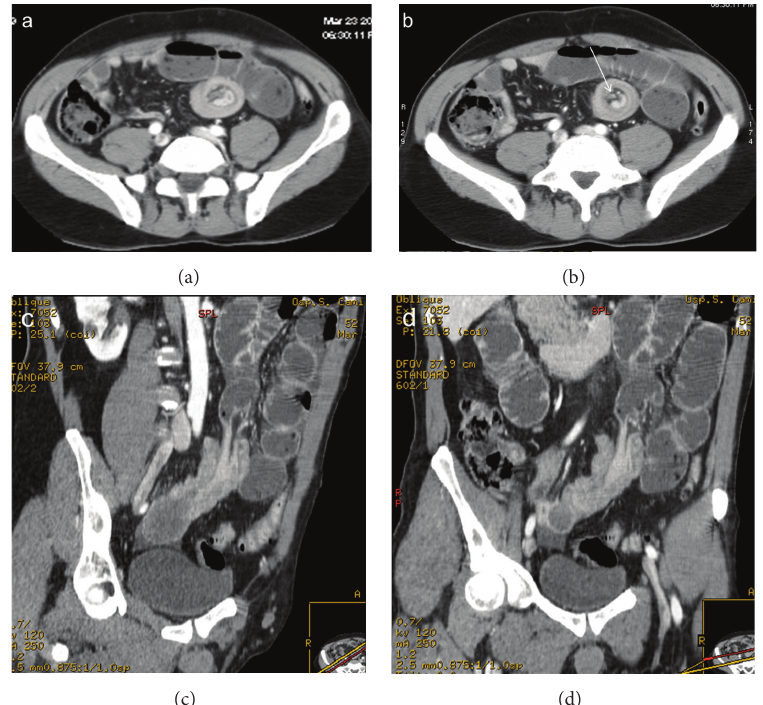
Figure 1: Enteroenteric intussusception. Axial CT images (a, b) demonstrate a round mass with “target” pattern and central hypodense area of mesenteric fat in which vessels are seen as linear enhanced structures (arrow). Oblique CT reformatted images (c, d) oriented parallel to the longitudinal axis of the intussusception depict intussusception as a large “sausage-shaped” mass, showing length of involvement. Gas-fluid levels in the dilated proximal loops are signs of small bowel